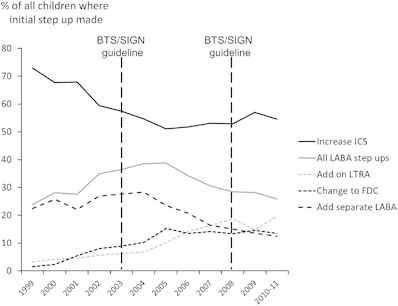
Proportion of step-up options over time in children with asthma already in receipt of inhaled corticosteroid treatment (ICS). All LABA, FDC plus LABA; FDC, fixed dose combination inhaler; LABA, addition of long-acting β2-agonist as separate inhaler; LTRA, leukotriene receptor antagonist. Data from 2010 and 2011 are combined since data from the whole of the calendar year 2011 were not available from CPRD. The vertical broken lines indicate when British Thoracic Society/Scottish Intercollegiate Guidelines network (BTS/SIGN) asthma guidelines were published.